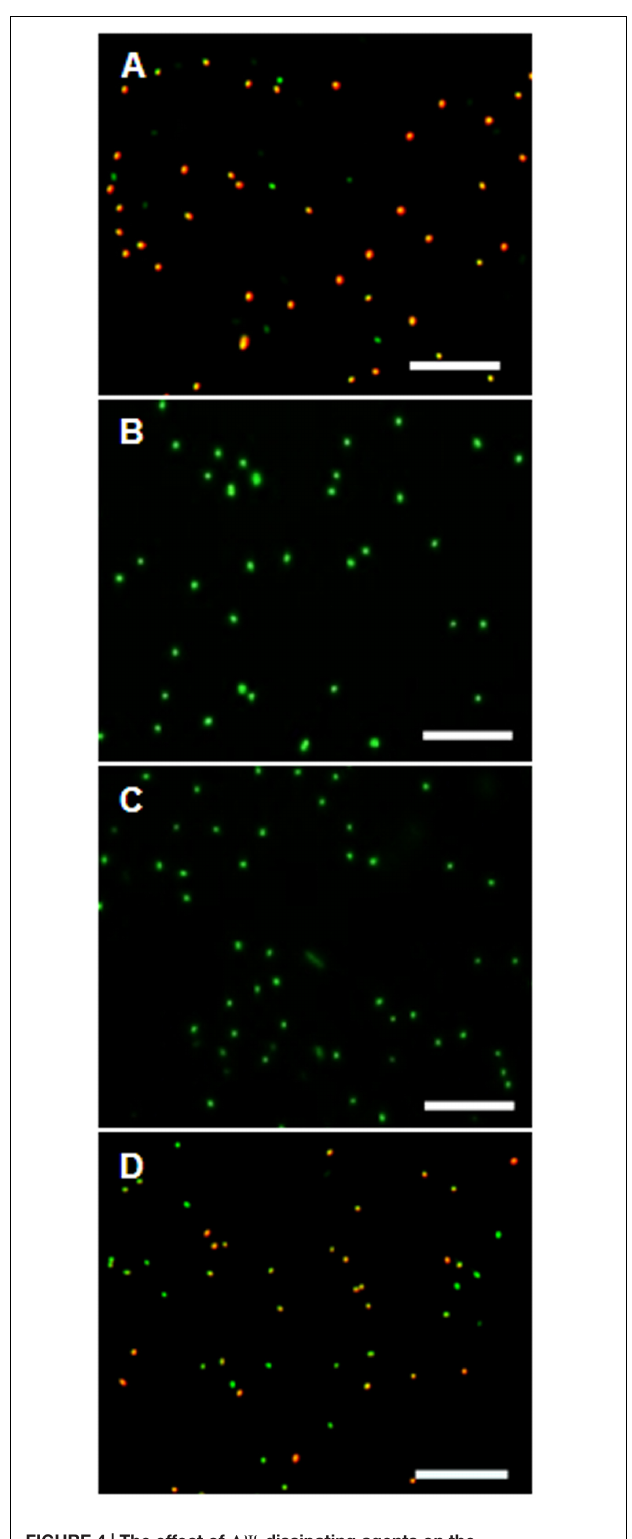
FIGURE 4 | The effect of (cid:49) (cid:57) -dissipating agents on the DiOC 2 (3)-uptake of D. shibae cells. (A) D. shibae cells with increased membrane potential. (B) 2 µ M CCCP. (C) 5 µ M TCS. (D) 5 µ g/ml gramicidin. All scales: 10 µ